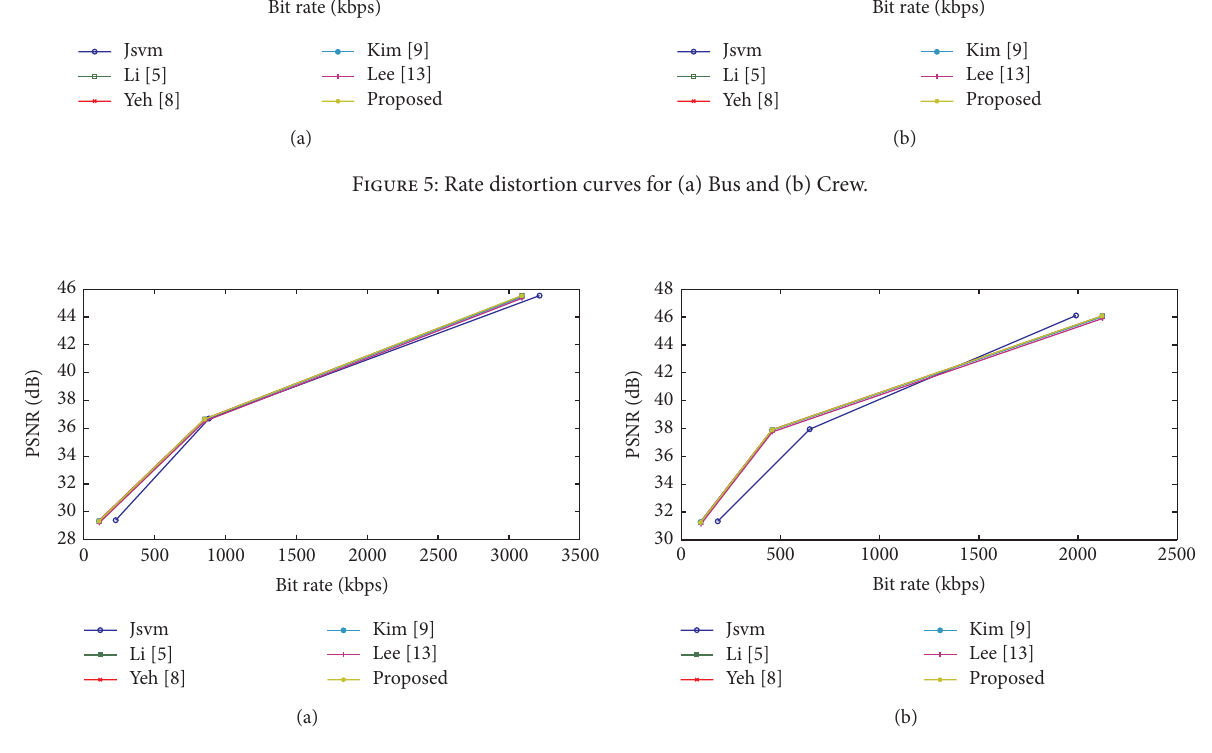
Figure 6: Rate distortion curves for (a) Harbour and (b) Soccer.